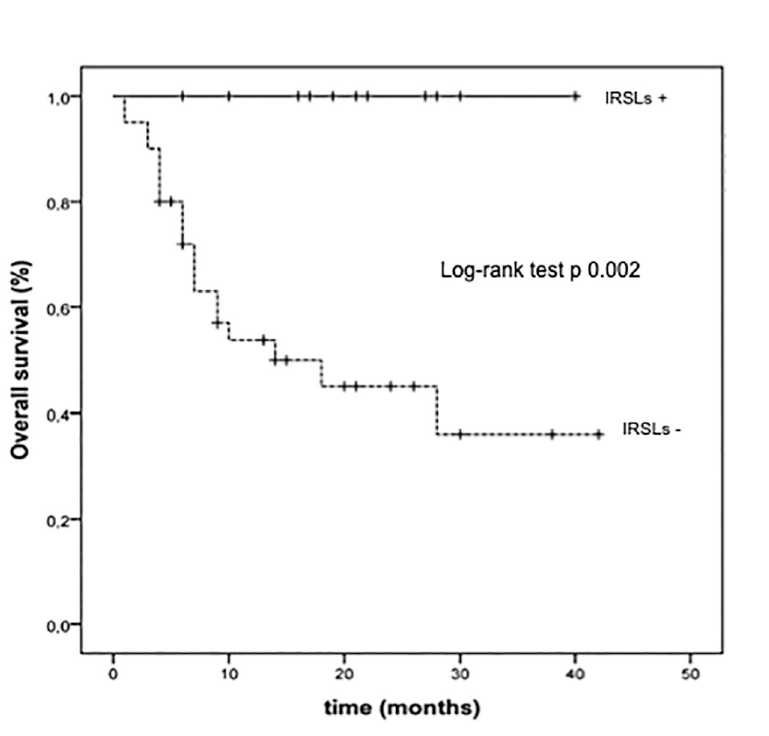
Fig 3. Kaplan Meier estimates of overall survival (OS) in patients with (IRSLs+) or without immune relate skin lesions (IRSLs-).